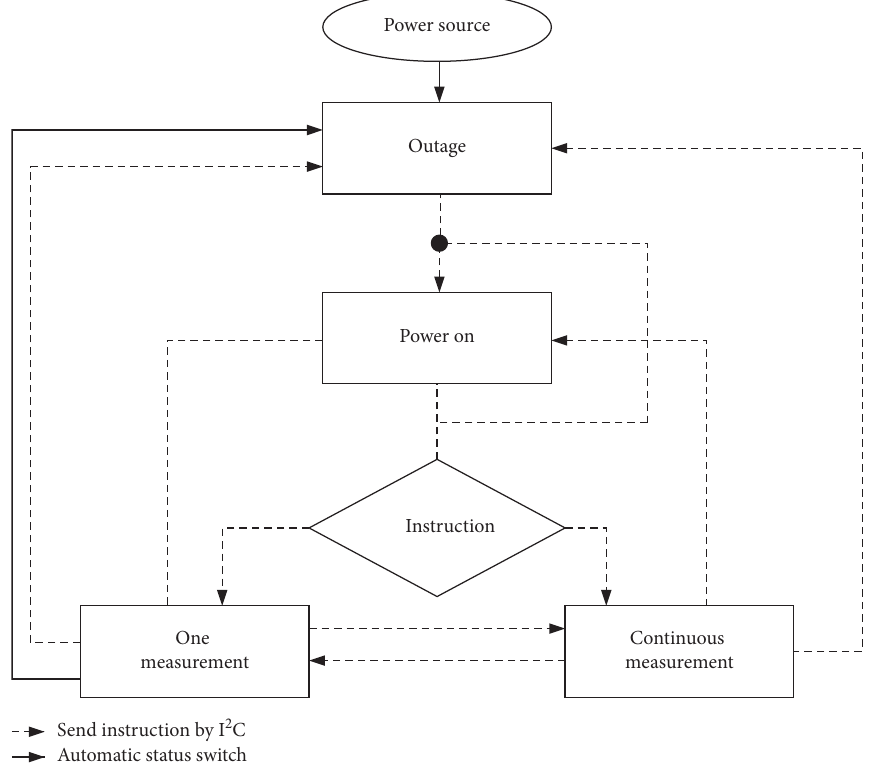
Figure 6: Procedure of light intensity sensor